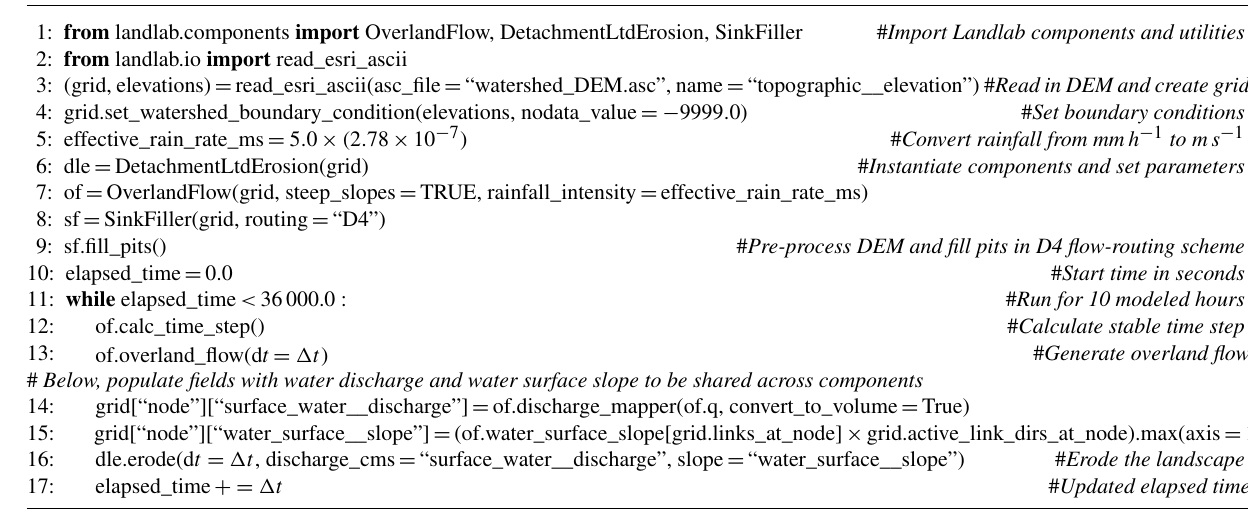
Algorithm 1 Sample Landlab overland flow and erosion